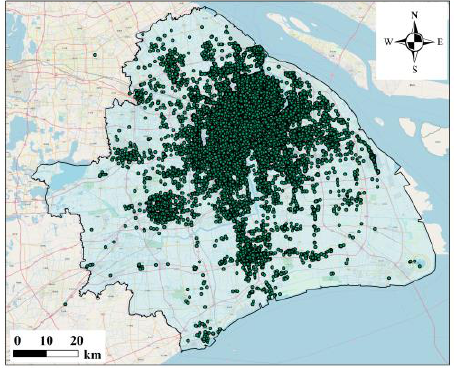
Figure 5. The distribution of origin points.